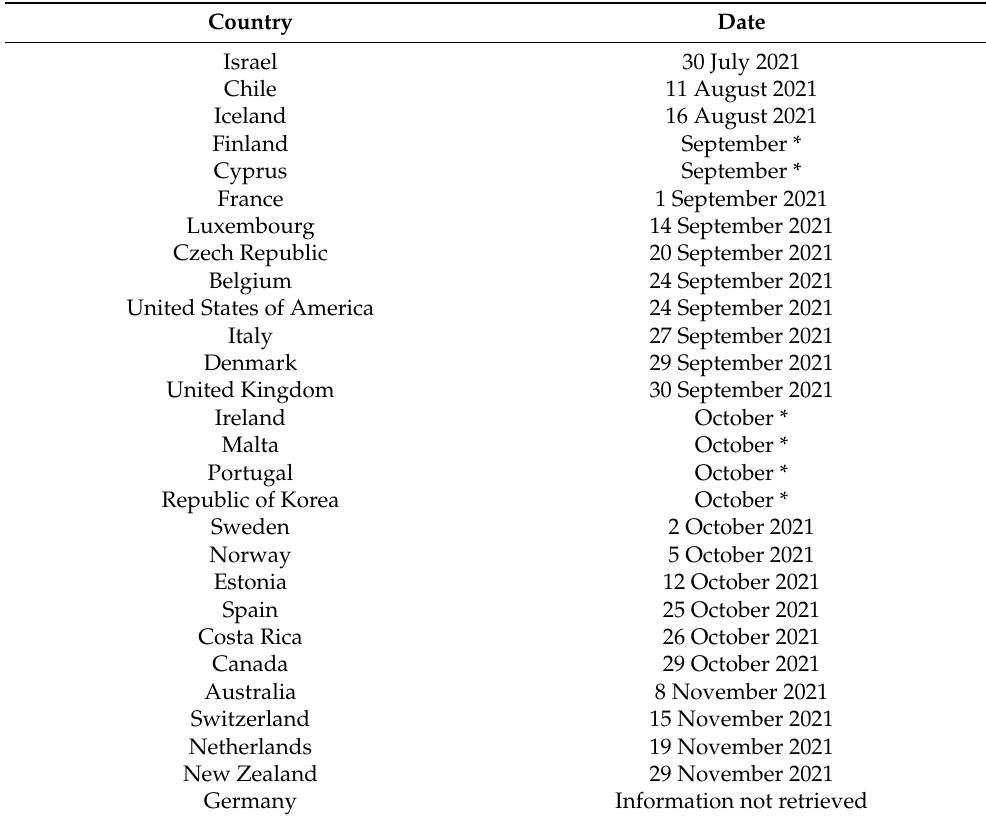
Table 1. Starting date of booster dose campaign.